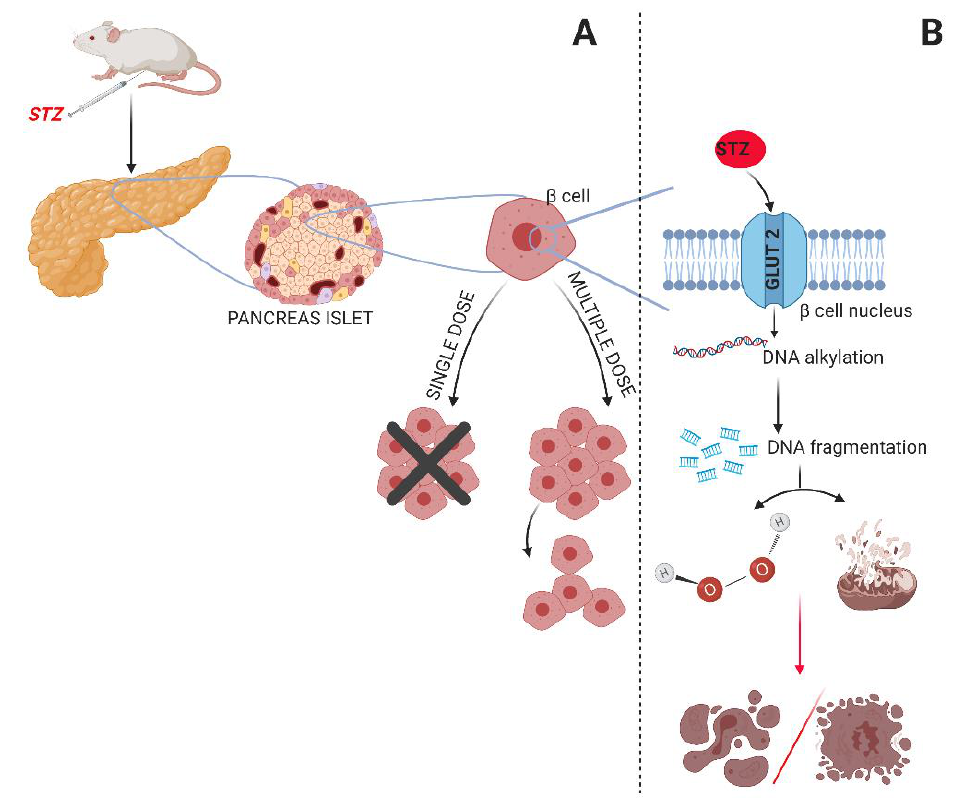
Figure 2. Diabetes induction model with STZ. ( A ) Mechanism of damage to pancreatic beta-cells with single or multiple doses of STZ. ( B ) Mechanism of action of STZ in the nucleus of β cells.